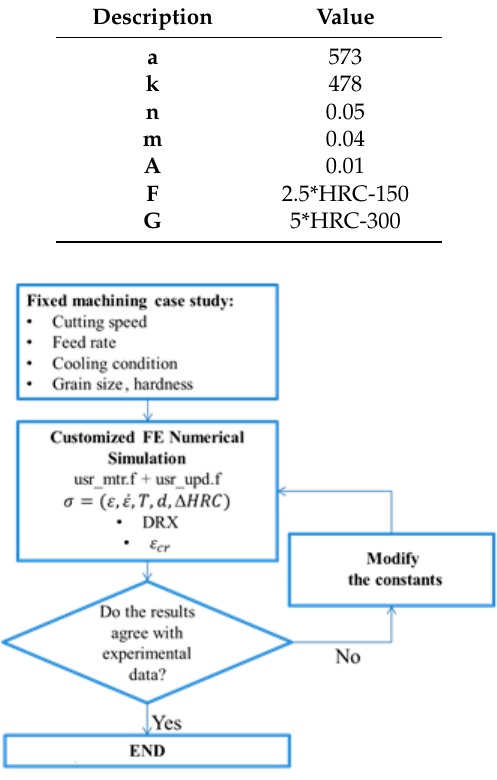
Figure 1. Iterative procedure to calibrate the constants.